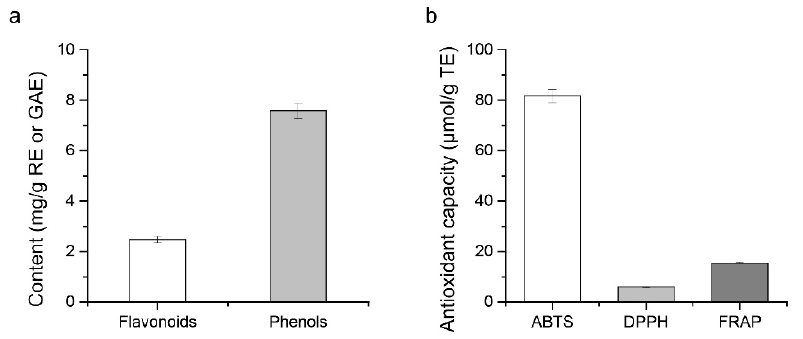
Figure 4. Bioactive substances ( a ) of FKJ and its antioxidant ability ( b